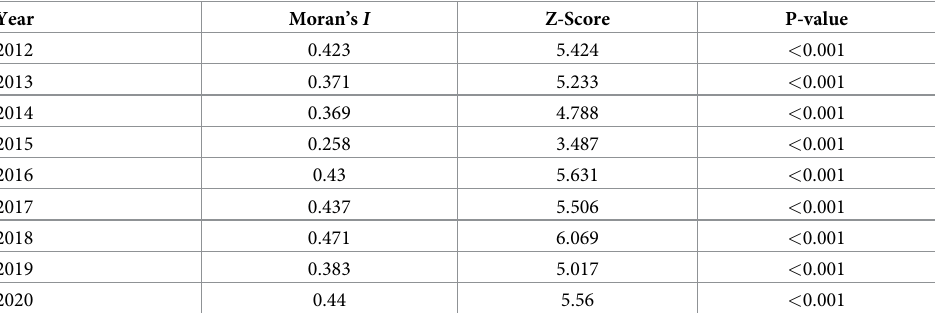
Table 2. Yearly spatial autocorrelation analysis on scrub typhus incidence in Fujian Province,